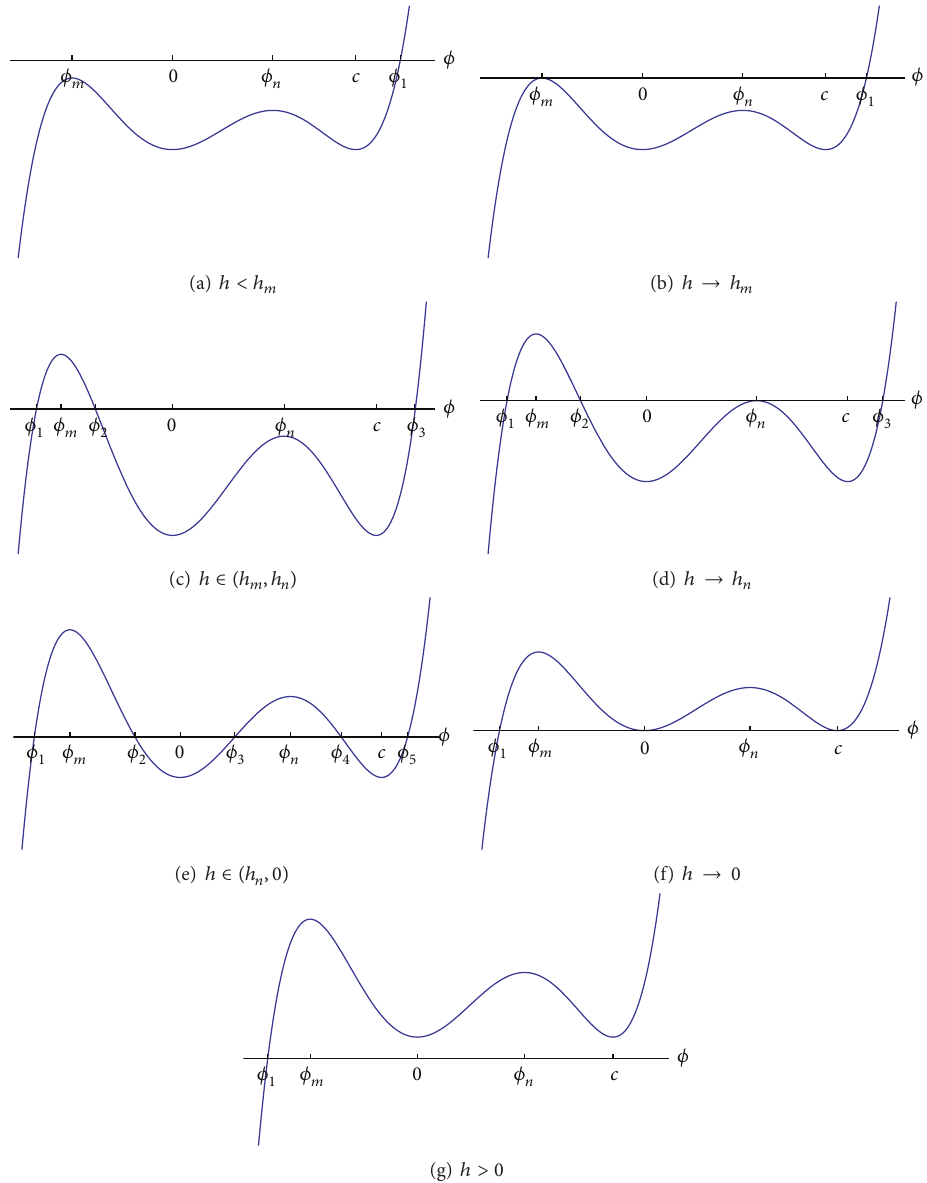
Figure 7: The graph of 𝐹(𝜙) as 𝑐 0 = (1/5)(5𝑐 − 2𝑐 2 )